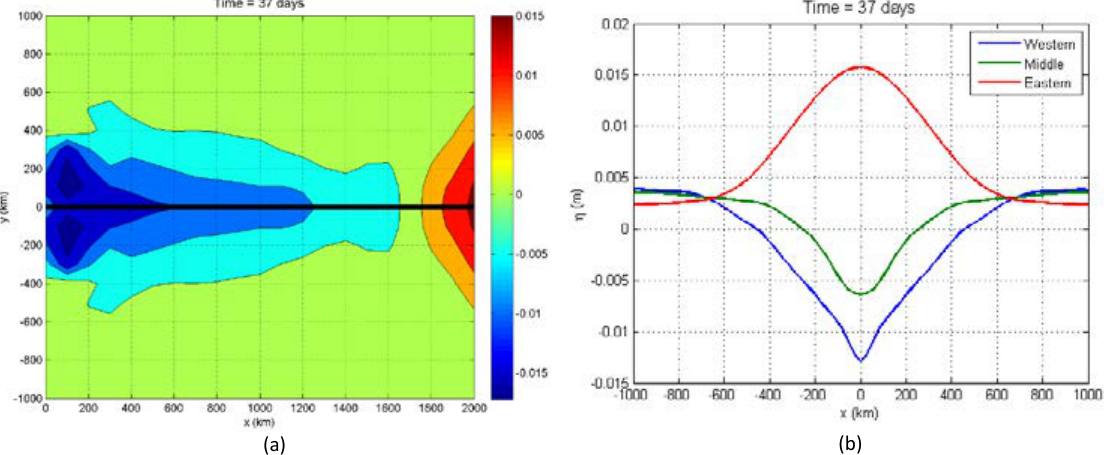
Fig. 4: Sea level (a) plot on the 37th day of simulation, (b) value at the equator on the 37th day